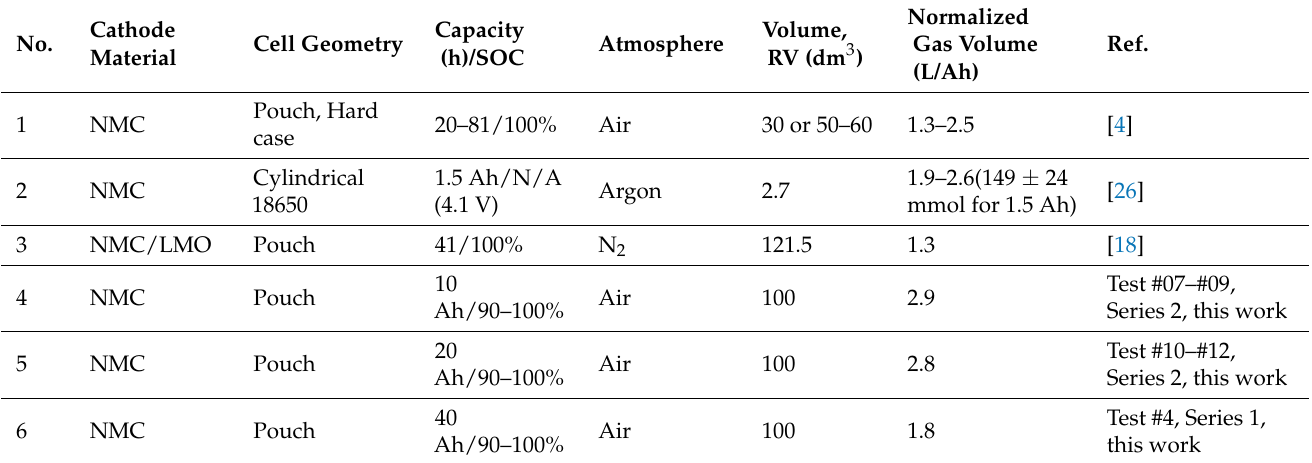
Table 3. Comparison of normalized volume of gas release with those of former